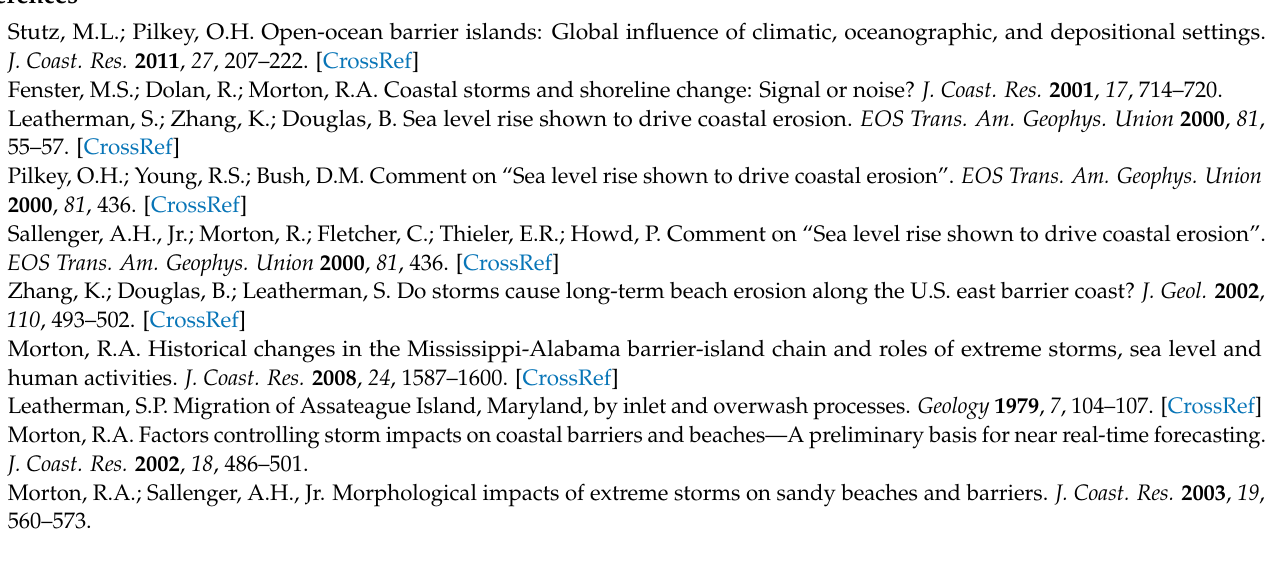
Napatree Barrier. Figure S3: 1939 Vertical aerial photograph of the Napatree Barrier. Figure S4: 1945 Vertical aerial photograph of the Napatree Barrier. Figure S5: 1951 Vertical aerial photograph of the Napatree Barrier. Figure S6: April 1962 Vertical aerial photograph of the Napatree Barrier. Figure S7: September 1963 Vertical aerial photograph of the Napatree Barrier. Original 9 × 9 Photograph scanned by Boothroyd and Hehre. Figure S8: April 1972 Vertical aerial photograph of the Napatree Barrier. Figure S9: April 1975 Vertical aerial photograph of the Napatree Barrier. Original 9 × 9 Photograph scanned by Boothroyd and Hehre. Figure S10: 1976 Vertical aerial photograph of the Napatree Barrier. Figure S11: April 1981 Vertical aerial photograph of the Napatree Barrier. Figure S12: March 1985 Vertical aerial photograph of the Napatree Barrier. Original 9 × 9 Scanned by Boothroyd and Hehre, 2007. Figure S13: April 1988 Vertical aerial photograph of the Napatree Barrier. Figure S14: March 1992 Vertical aerial photograph of the Napatree Barrier. Figure S15: Spring 1997 Digital Orthophotograph of the Napatree Barrier. Figure S16: April 2004 Digital Orthophotograph of the Napatree Barrier. Figure S17: Spring 2008 Digital aerial photograph of the Napatree Barrier. Figure S18: June 2012 Digital Orthophotograph of the Napatree Barrier. Figure S19: April 2014 Digital Orthophotograph of the Napatree Barrier. Figure S20: April 2018 Digital Aerial Photograph of the Napatree Barrier. Table S1: Water levels exceeding the 0.7 m MHHW threshold at the Newport, RI and New London tide gauges. Table S2: Average distance from baseline and standard deviation of shoreline position used in this analysis. See Table 3 for the sources of the